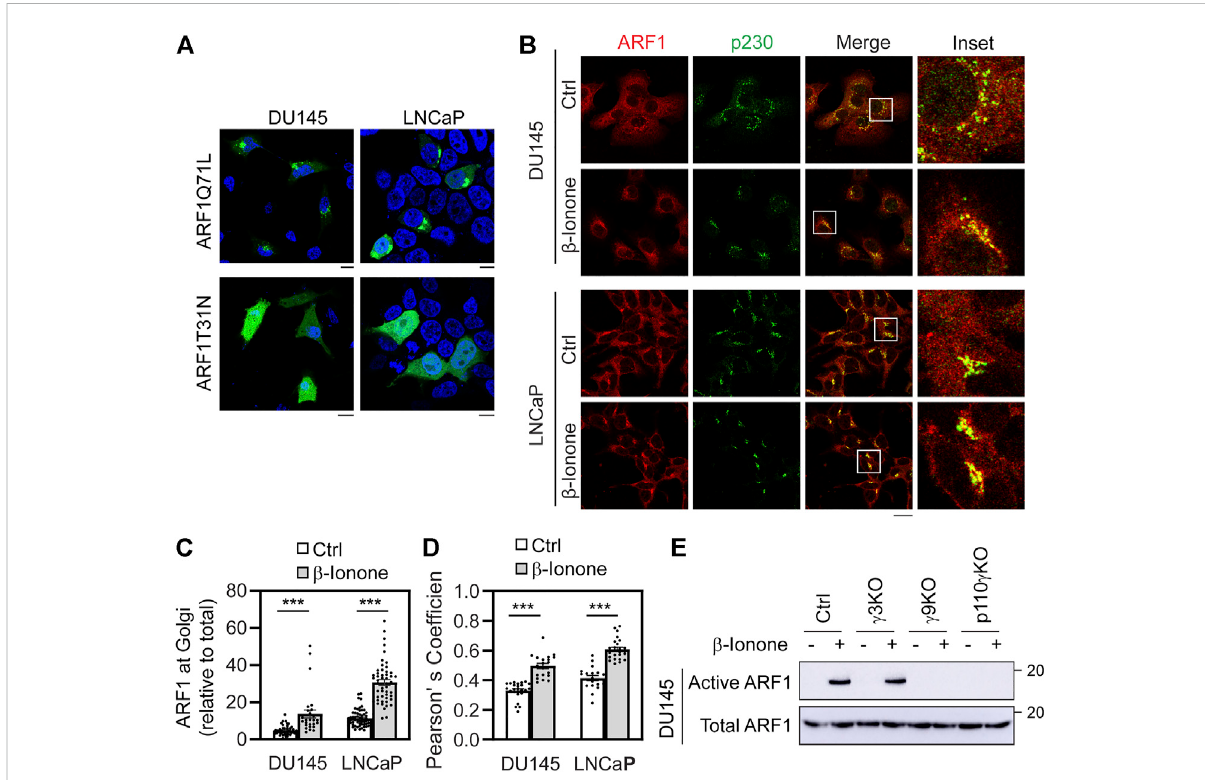
FIGURE 4 Stimulation with β -ionone recruits ARF1 to the GA and activates ARF1 via G βγ and PI3K γ in prostate cancer cells. (A) Subcellular distribution of ARF1Q71L and ARF1T31N in DU145 and LNCaP cells. The cells were transfected with GFP-tagged ARF1 active or dominant negative mutant for 24 h and the subcellular distribution of ARF1 mutants was revealed by confocal microscopy. (B) ARF1 translocation to the GA after β -ionone stimulation. The cells were starved for 48 h, stimulated with β -ionone at 100 μ M for 5 min and then stained with antibodies against ARF1 and p230. (C) Quanti fi cation of ARF1 expression at the GA by using p230 as a GA marker. (D) Quanti fi cation of Pearson ’ s coef fi cient between ARF1 and p230. (E) ARF1activation inG γ 3,G γ 9,andp110 γ KOcellsinresponseto β -iononestimulation.DU145KOcellswerestarvedfor48 hbeforestimulationwith β - iononeat100 μ Mfor5 min.ARF1activation wasmeasuredinGSTfusionproteinpulldownassays.Thequantitative dataarepresentedasmeans±SE ( n = 29 – 43 cells in C and 18 – 25 cells in D in three individual experiments). ***, p < 0.001 versus respective control. Scale bar: 10 μ m. The Western blots shown are representatives of three